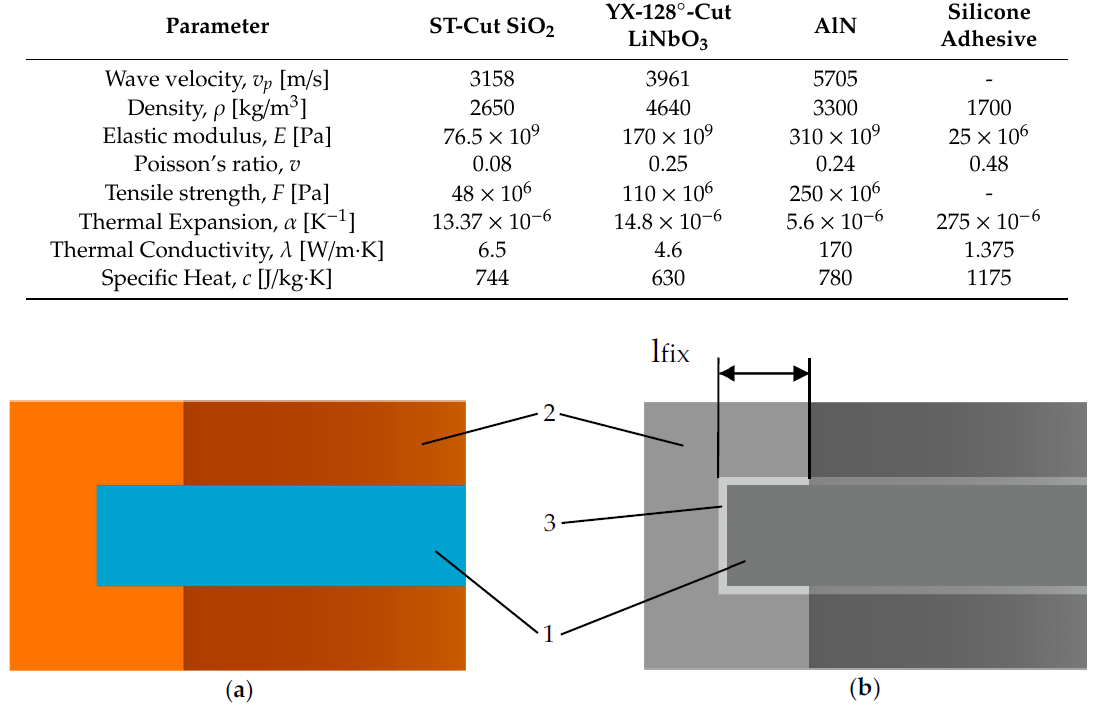
Figure 3. Console attachment methods: rigid ( a ) and using silicone adhesive ( b ): 1: console; 2: housing; 3: silicone adhesive.